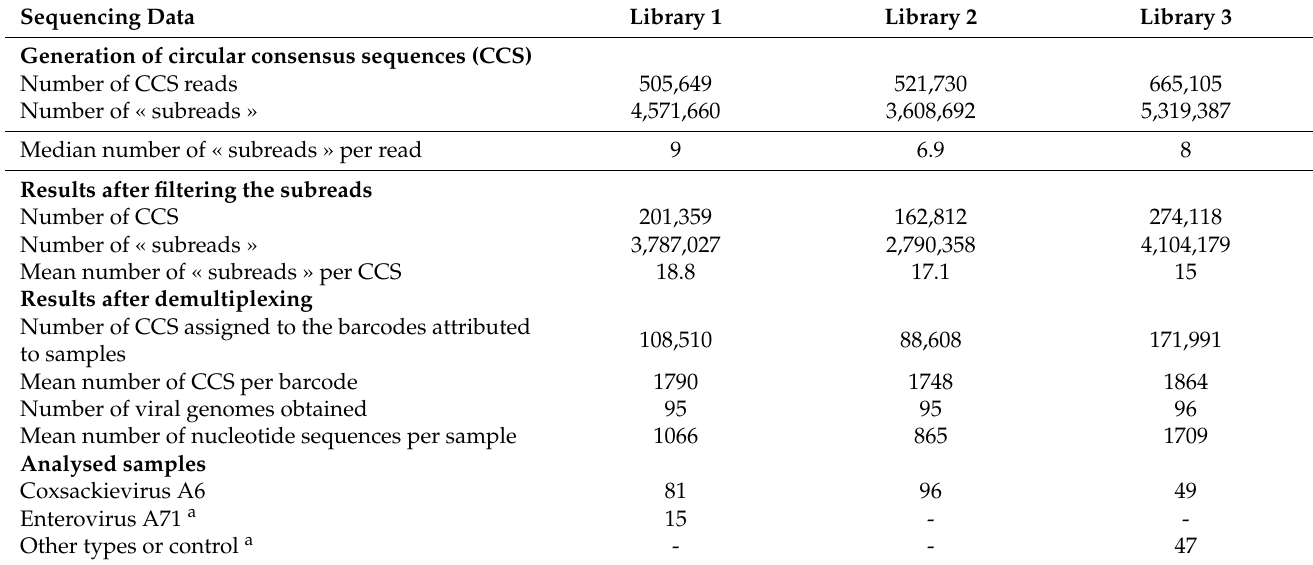
Table 2. Coxsackievirus A6 whole-genome sequencing